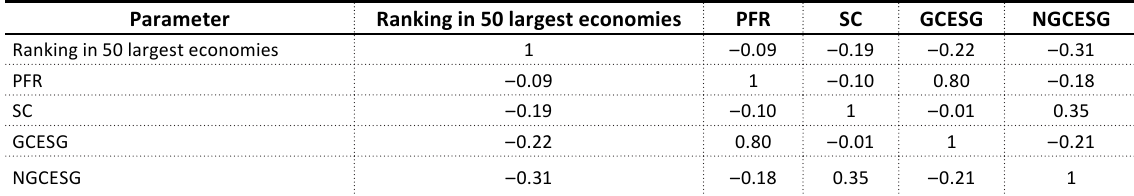
Table D2. Correlation analysis of ESG disclosure regulation and overall competitiveness of the countries: case of developed countries